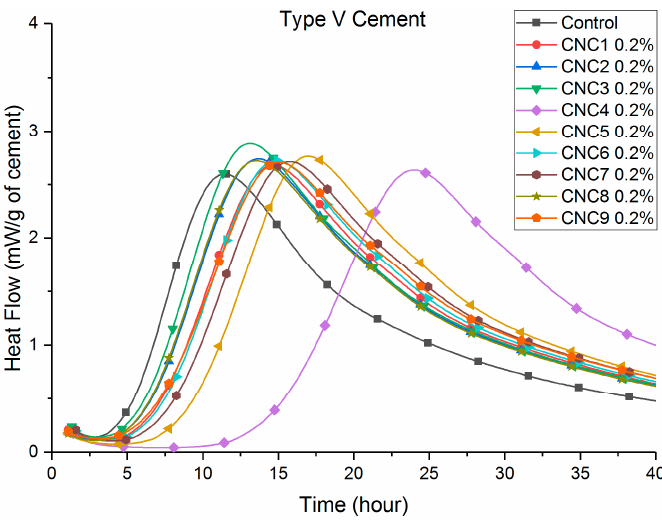
Figure 3. Heat flow of Type V cement, different CNCs.